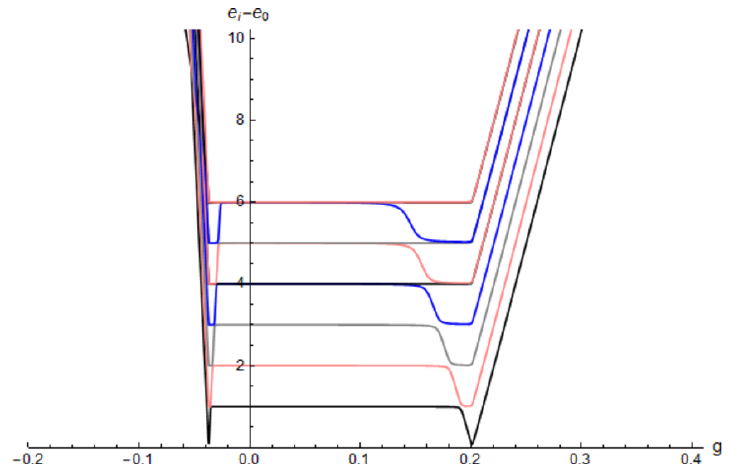
Figure 17. Perturbation of NS (13) fermions by the quartic term for both positive and negative coupling with (cid:1) max = 25 :